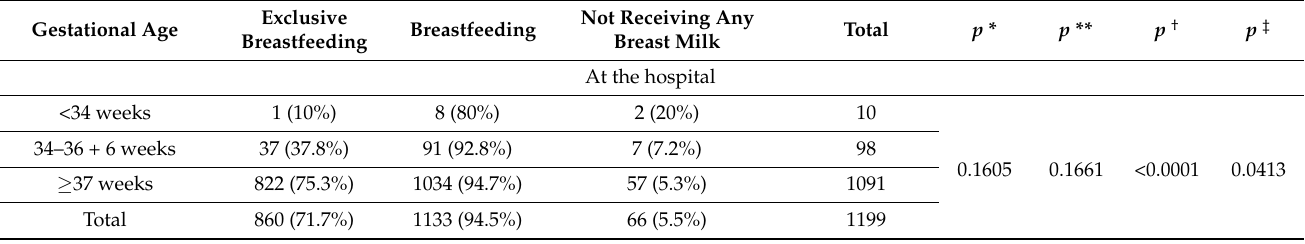
Table 5. The relationship between the gestational age of the newborn and the rates of the exclusive breastfeeding, the breastfeeding and the infants who did not receive any breast milk by infants’